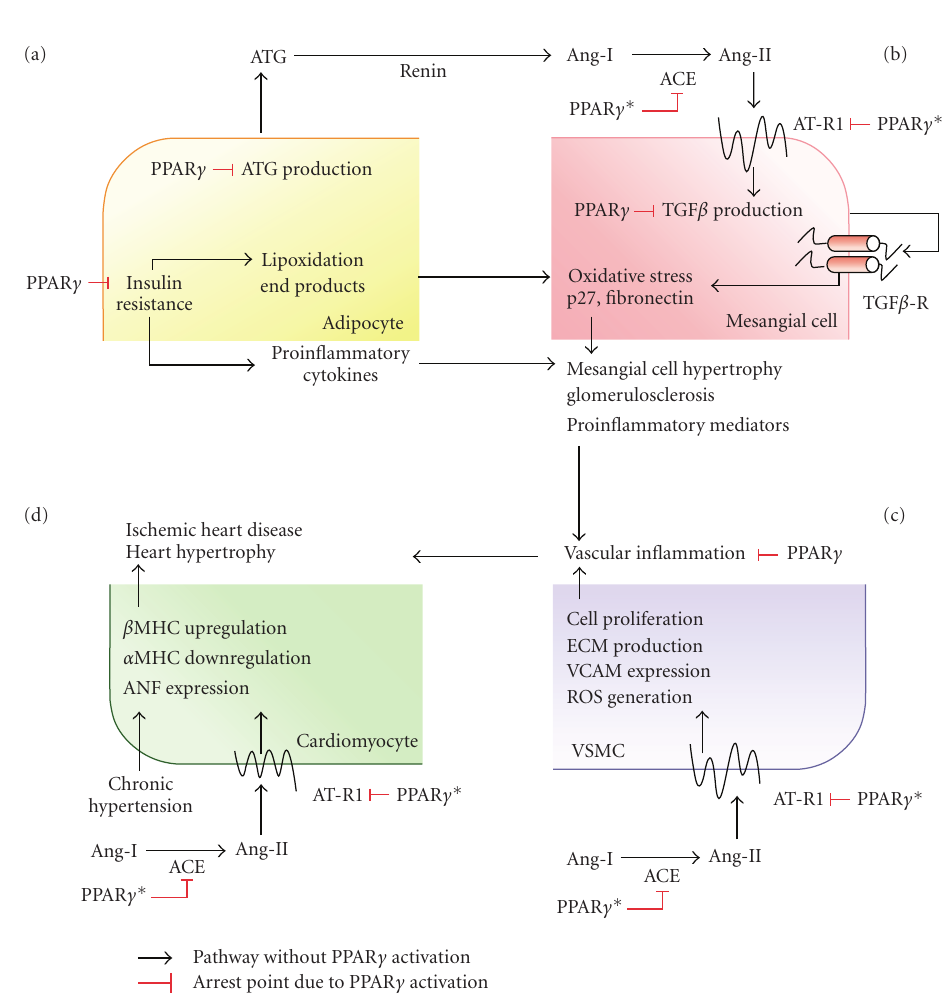
Figure 3: Paracrine e ff ects of the RAAS and their modulation by PPAR γ . In adipocytes (a) PPAR γ activation is suggested to reduce ATG synthesis, impeding RAAS activation; this can ameliorate hypertension in obese diabetic patients. Independently of RAAS modulation, PPAR γ improves insulin action in adipocytes, reducing the production of proinflammatory cytokines and reducing the risk of atherogenesis and nephropathy. In kidney mesangial cells (b) PPAR γ activation reduces TGF β -mediated hypertrophy and downregulates expression of AT-R1 and ACE. Some PPAR γ ligands, such as telmisartan, combine AT-R1 blocking and ACE inhibitor properties, e ff ectively inhibiting the proinflammatory actions of Ang-II in the kidney. This dual action can also reduce vascular inflammation resulting from VSMC dysfunction (c) and cardiomyocyte hyprtreophy in chronic hypertension (d). We labeled with asterisks PPAR γ , where its ligands can act through both direct AT-R1 inhibition and downregulation of ACE/AT-R1 gene expression. TGF β : transforming growth factor- β , ECM: extracellular matrix, VCAM: vascular cell adhesion molecule, ROS: reactive oxygen species, α MHC/ β MHC: myosin heavy chain α/β , ANF: atrial natriuretic